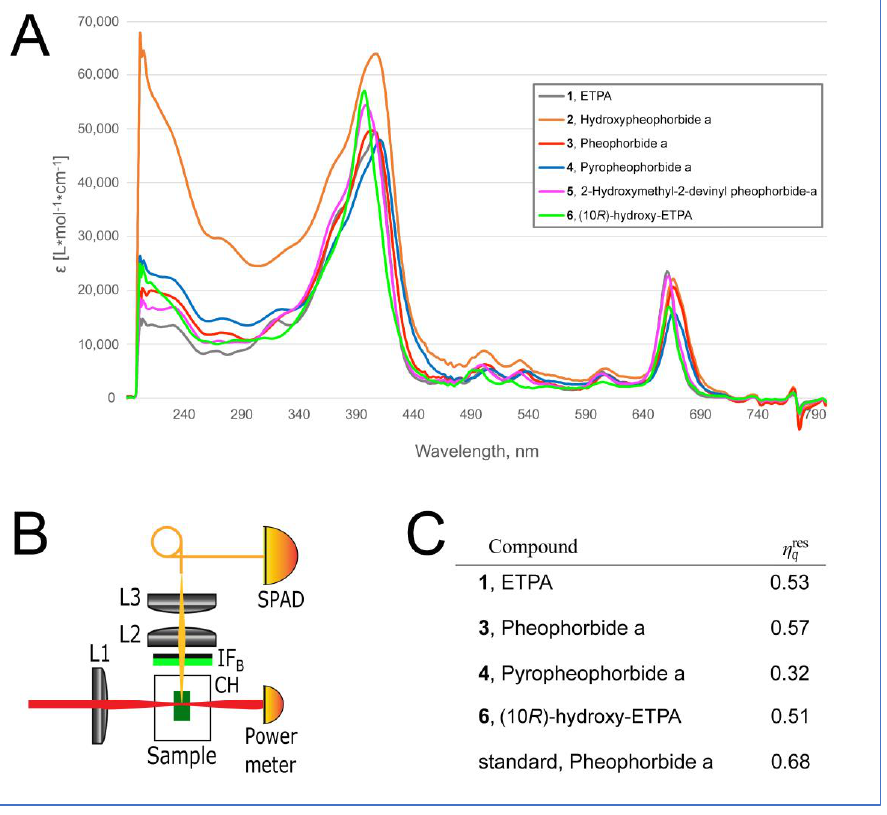
Figure 5. Physical properties of chlorin compounds from O. sarsii. ( A ) UV-Vis absorbance spectra of the chlorins. ( B ) Scheme of the device for measurement of the singlet oxygen generation. IF B — bandpass interference filter; L1 — laser beam focusing lens; Sample — cell with chlorin solution; CH — cuvette holder; L2 — singlet oxygen phosphorescence collecting lens; L3 — phosphorescence focusing lens; SPAD — single-photon avalanche diode. ( C ) Quantification of the relative singlet oxygen quantum yield.